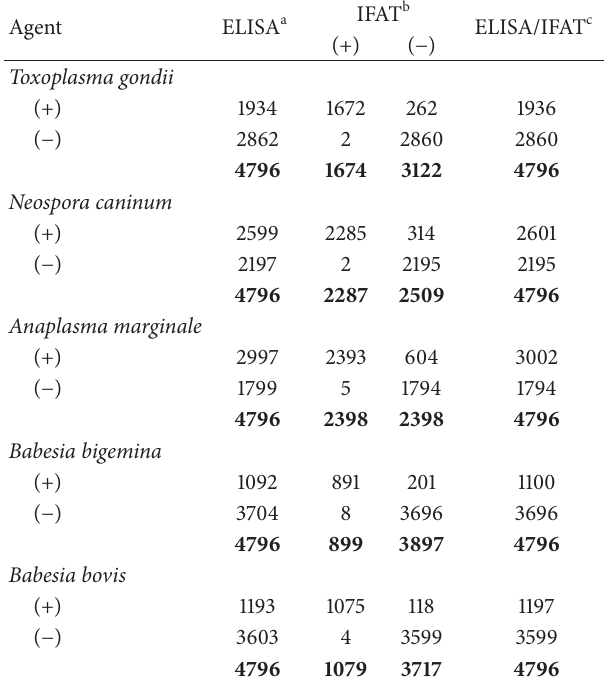
Table 1: Summary of the serological detection of T. gondii, N. caninum, A. marginale, B. bovis , and B. bigemina using ELISA and IFAT. The results of ELISA were cross-tabulated with those of